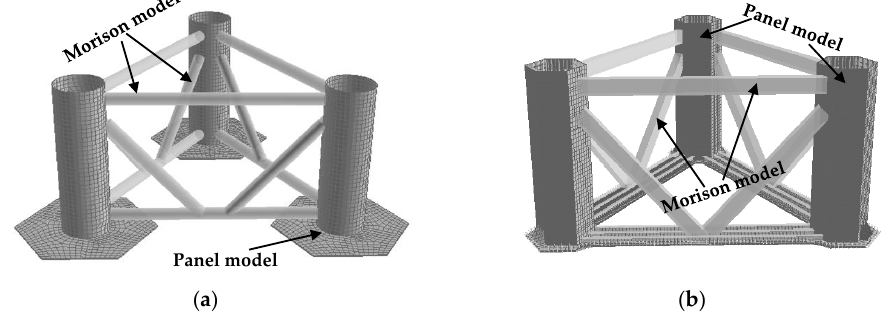
Figure 3. ( a ) WindFloat-type platform and ( b ) HexaSemi WADAM models.